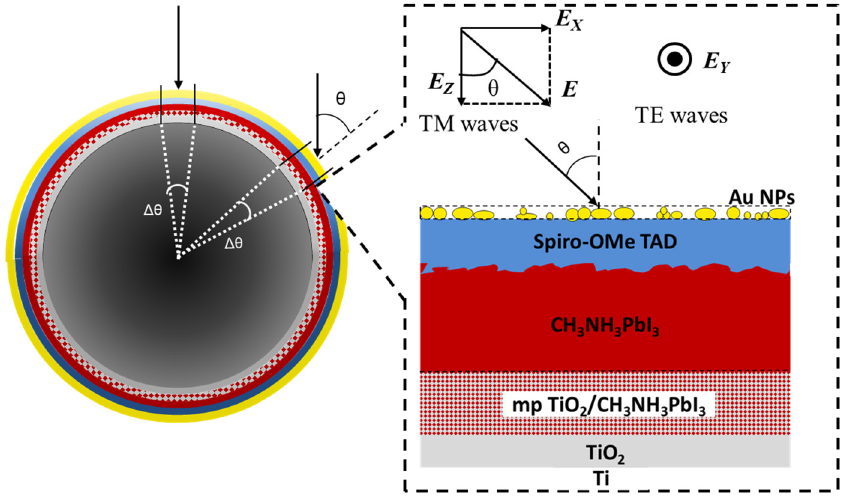
Figure 2. Light incidence on the cylindrical structure (which was divided in almost planar segments) and detail of a typical segment. and detail of a typical